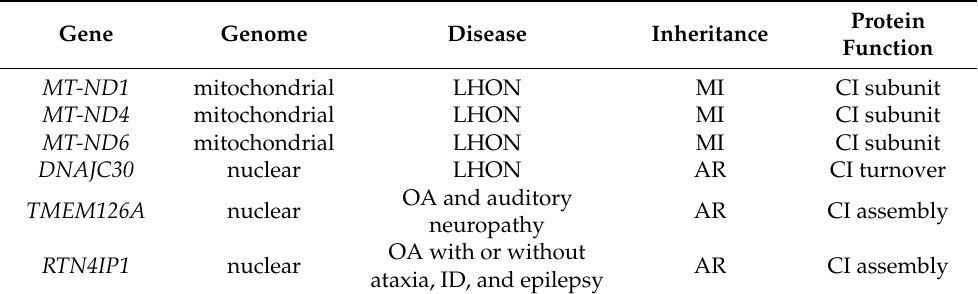
Table 1. Main genes associated with Complex I dysfunction leading to optic